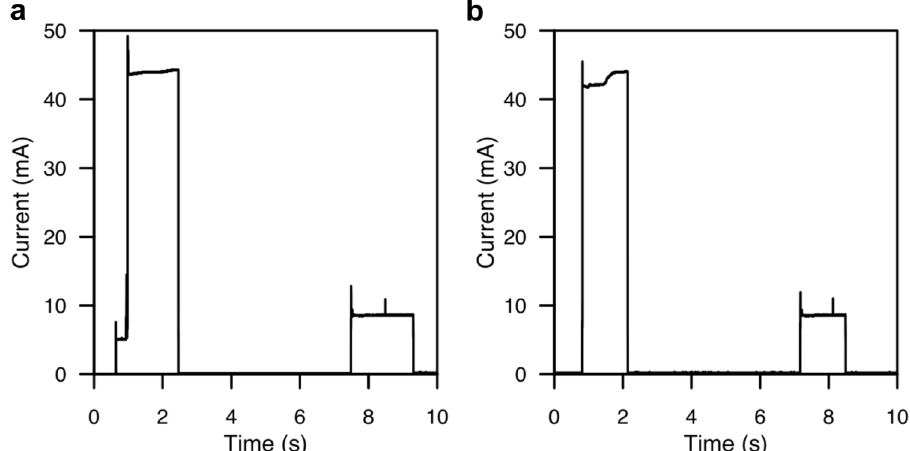
Figure 3. Current consumption waveforms of the back-end module. ( a ) During microcontroller’s initialization and LoRaWAN over-the-air activation. ( b ) During a LoRaWAN transmission.